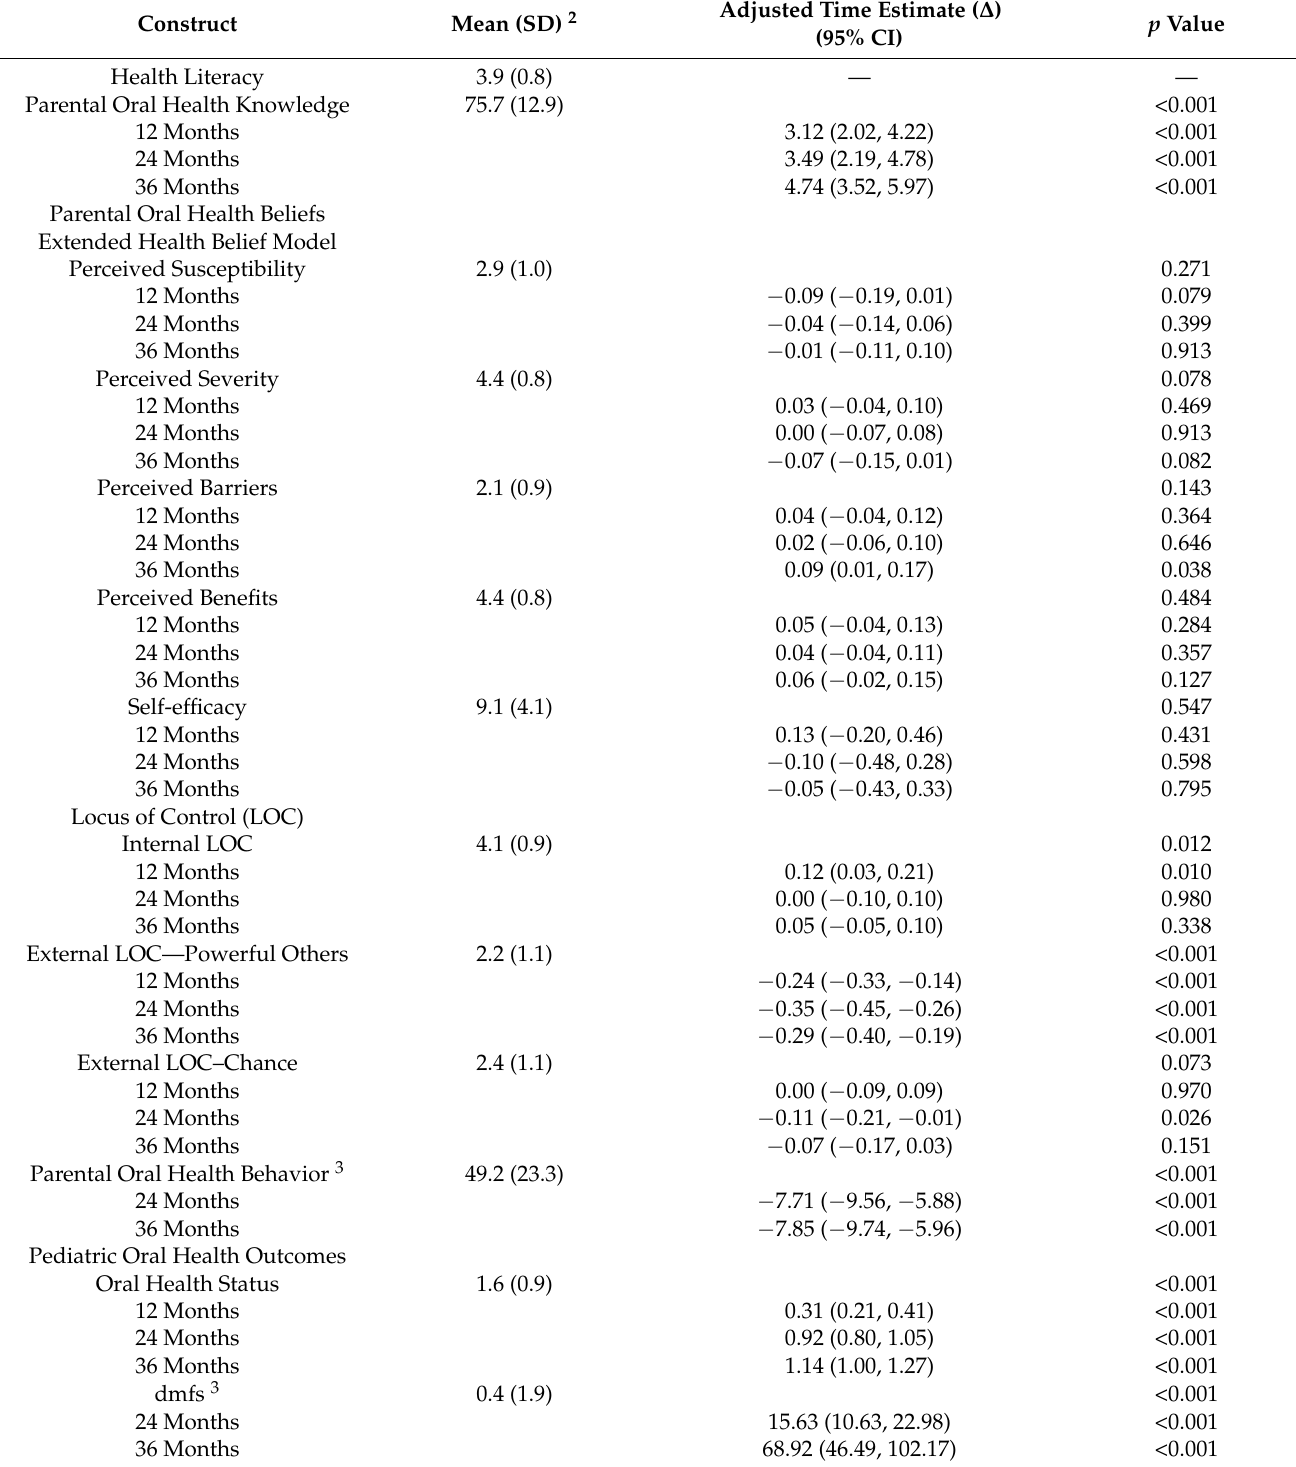
Table 1. Initial Performance and Change over Time in Constructs of Interest 1